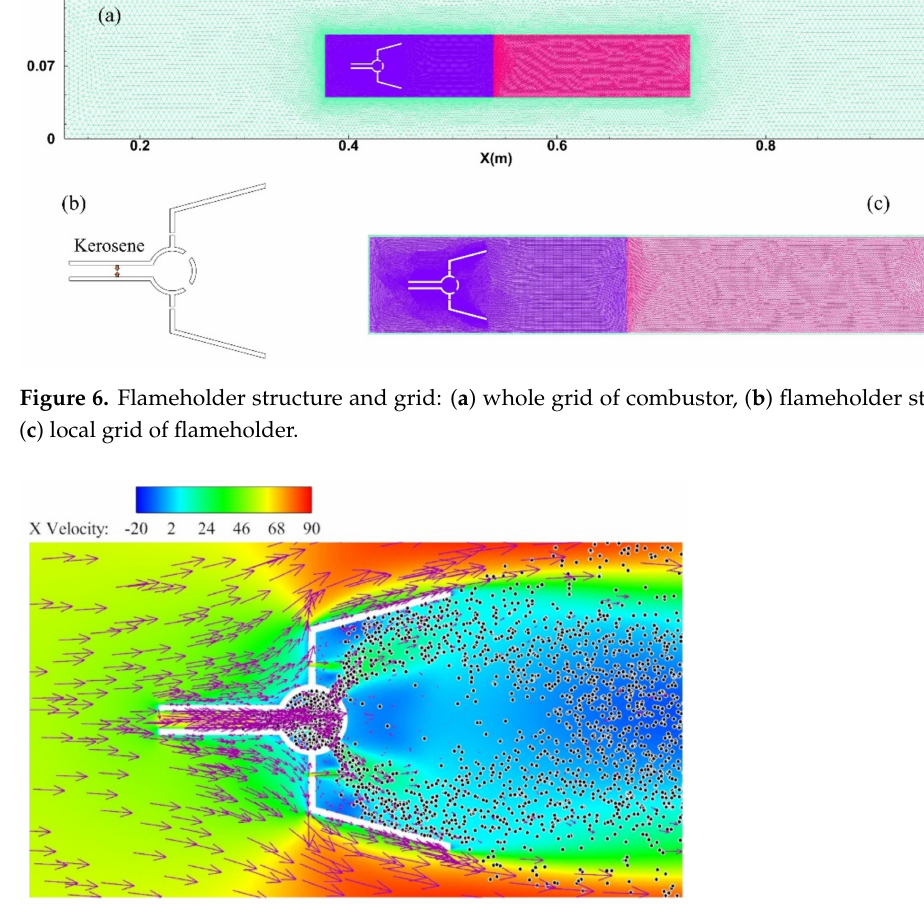
Figure 7. The basic characteristics of the spray field.